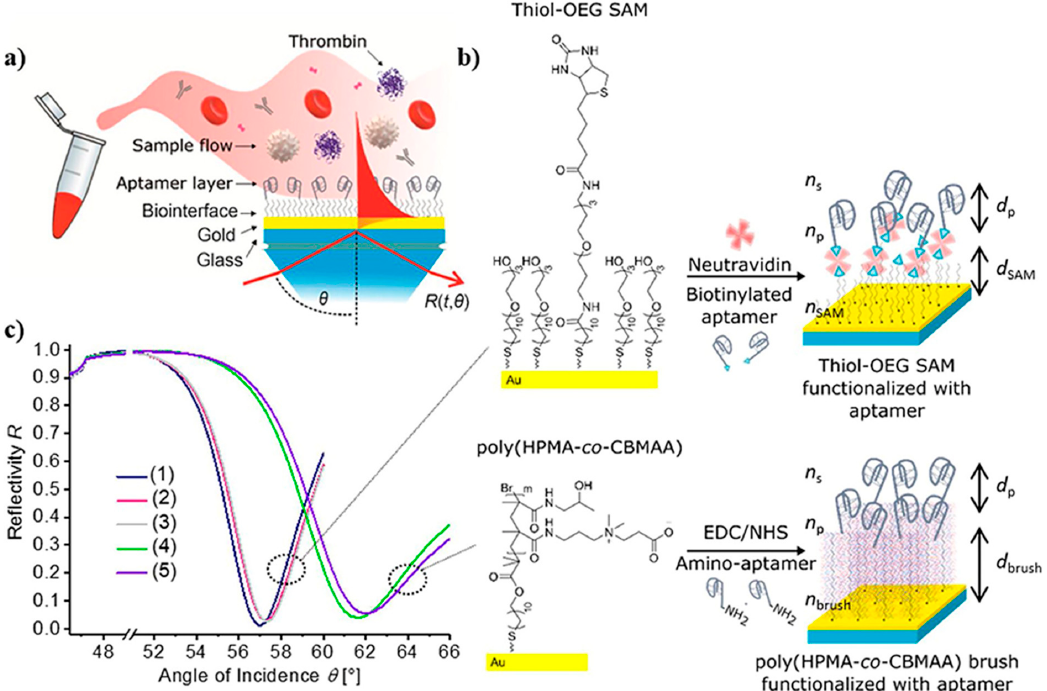
Figure 9. Surface plasmon resonance-based aptasensor for TB determination: ( a ) SPR sensor chip, ( b ) architectural design of thiol-OEG SAM or poly(HPMA-co-CBMAA) architecture and functionalized with aptamer, and ( c ) reflection at an angle of SPR spectra obtained at a specific wavelength on an SPR sensor chip includes (1) thiol-OEGSAM, (2) thiol-OEG SAM with neutravidin, (3) a comparison of spectra (1 and 2) with (4 and 5), (4) pristine polymer brushes, and (5) polymer brushes functionalized with aptamer HD22 [132].